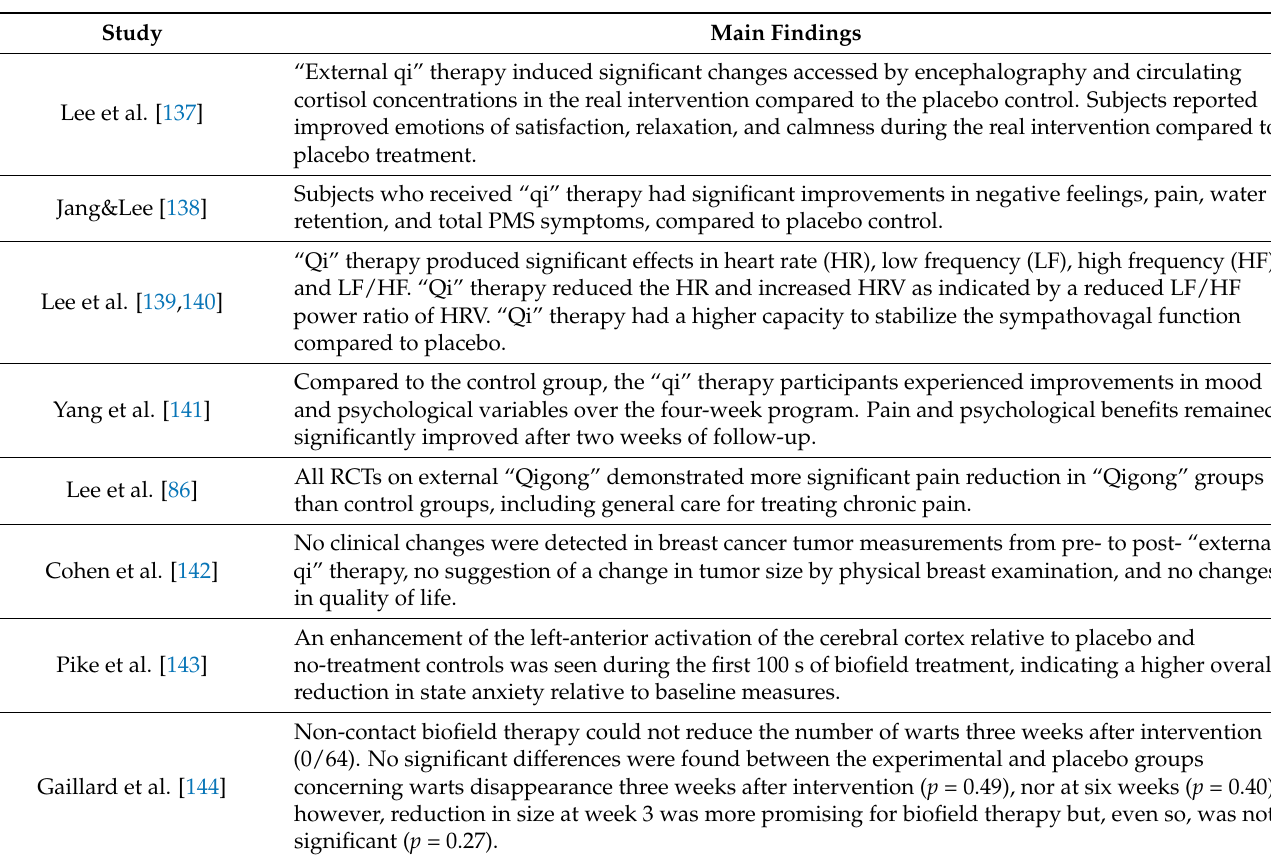
Table 3. Research exploring the effects of non-contact biofield practices on the human body. Study Main